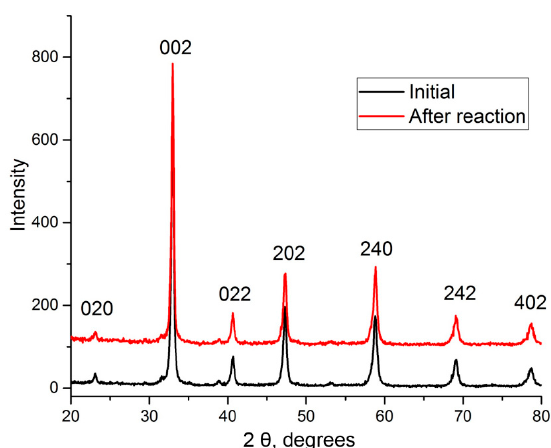
Figure 4. XRD patterns of the fresh (black line) and spent (red line) La 0.5 Ca 0.5 Mn 0.5 Fe 0.5 O 3 .